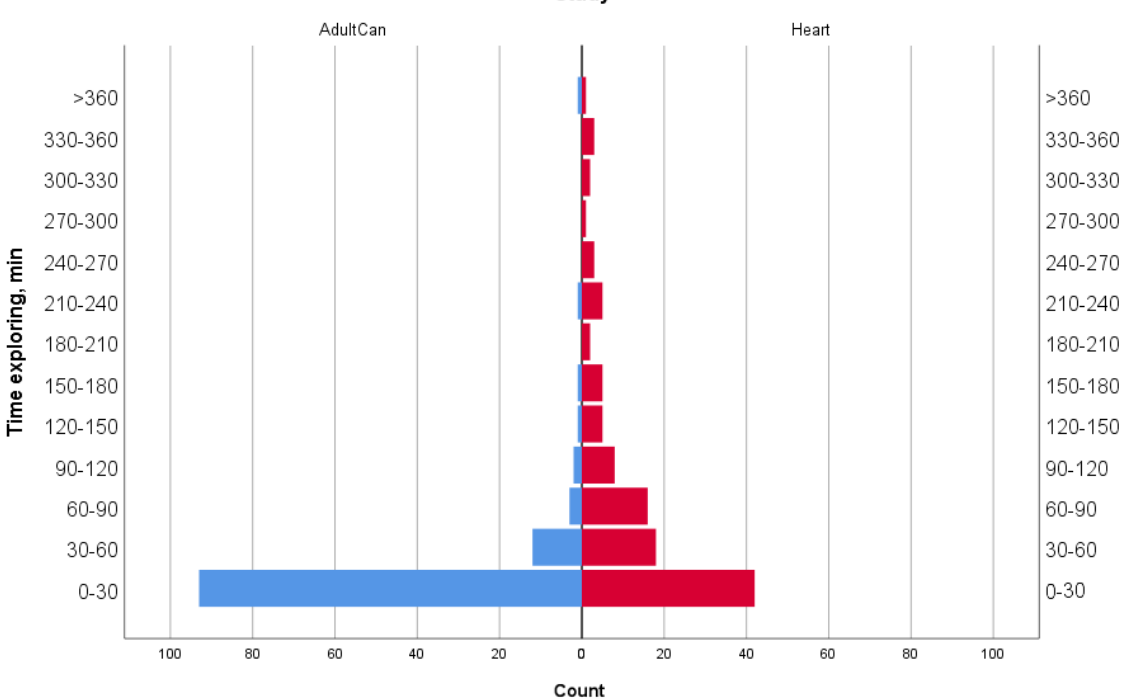
Figure 2. Total time spent in exploring the intervention within 14 days after randomization by number of participants in the treatment group in AdultCan and Heart